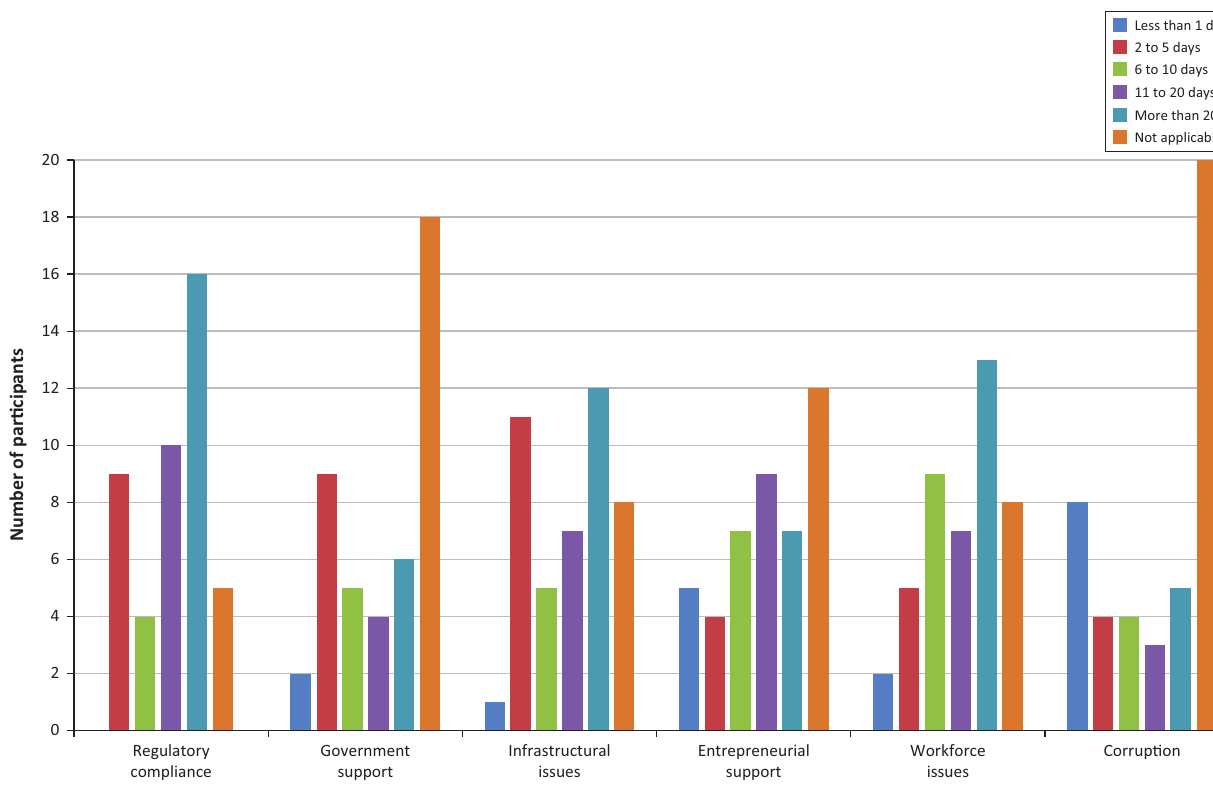
FIGURE 7: Time impact of the challenges faced on an annual basis.